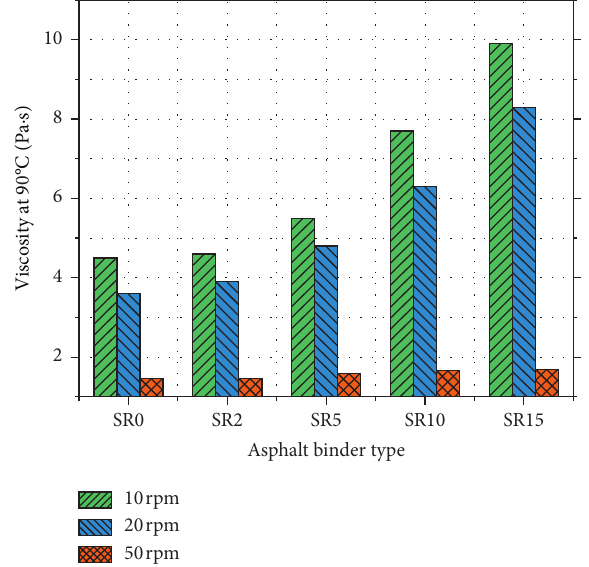
Figure 7: The viscosity of different asphalt binders with different rotational speeds at 90 °